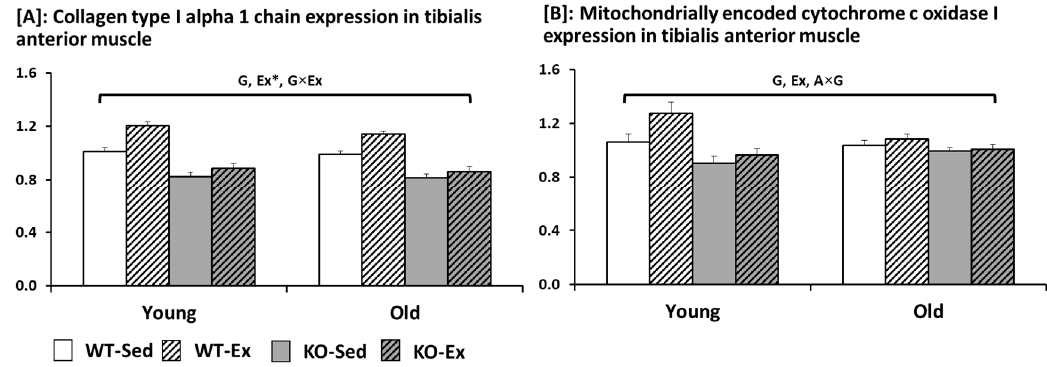
Figure 1. Expression of both collagen type I alpha 1 chain (COL1A1) (A) and mitochondrially encoded cytochrome c oxidase I (MT-CO1) (B) in the tibialis anterior muscle. The results indicate an effect of genotype G (WT > KO) for both proteins and an effect of exercise Ex (Ex > Sed) for COL1A1 (trend) and MT-CO1. For the interactions, we have one between genotype and exercise G × Ex for COL1A1 (Ex > Sed in WT) and one between age and genotype A × G for MT-CO1 (high in Y-WT). All data are mean ± SEM. The number of mice: 11–12 mice per experimental condition. Abbreviations: A, age; Ex, exercise; G, genotype; KO, knockout; O, old; Sed, sedentary; WT, wild-type; Y, young. *: Trend (0.05 ≤ p < 0.1).